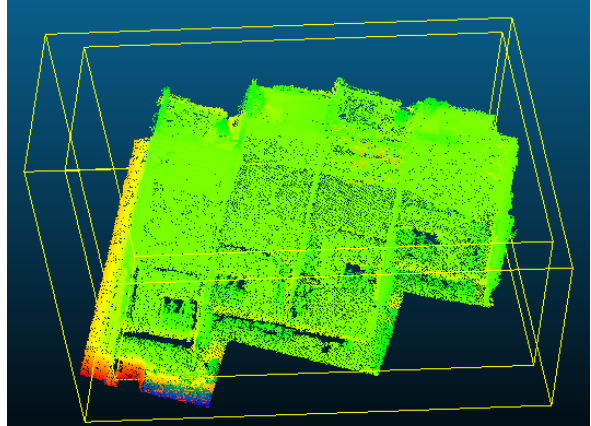
Figure 15. Visualization of the distribution of point cloud intersections against fields